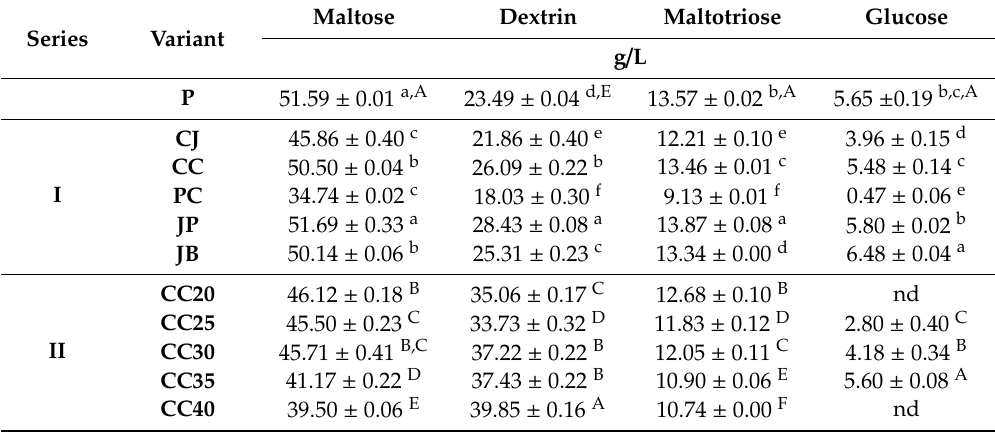
Table 1. Carbohydrate profile of wort with the addition of special